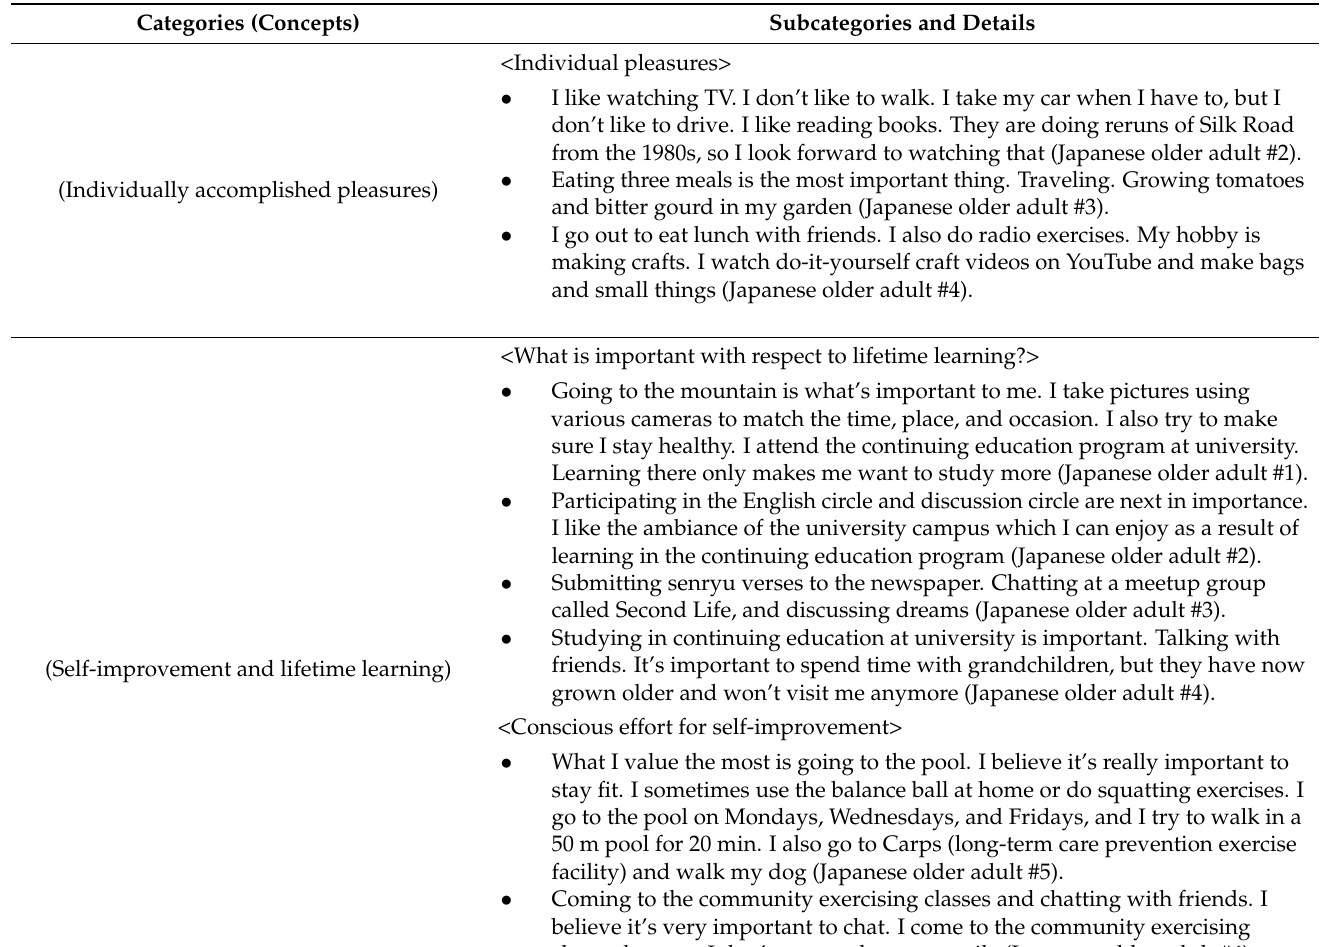
Table 2. The Japanese older adults’